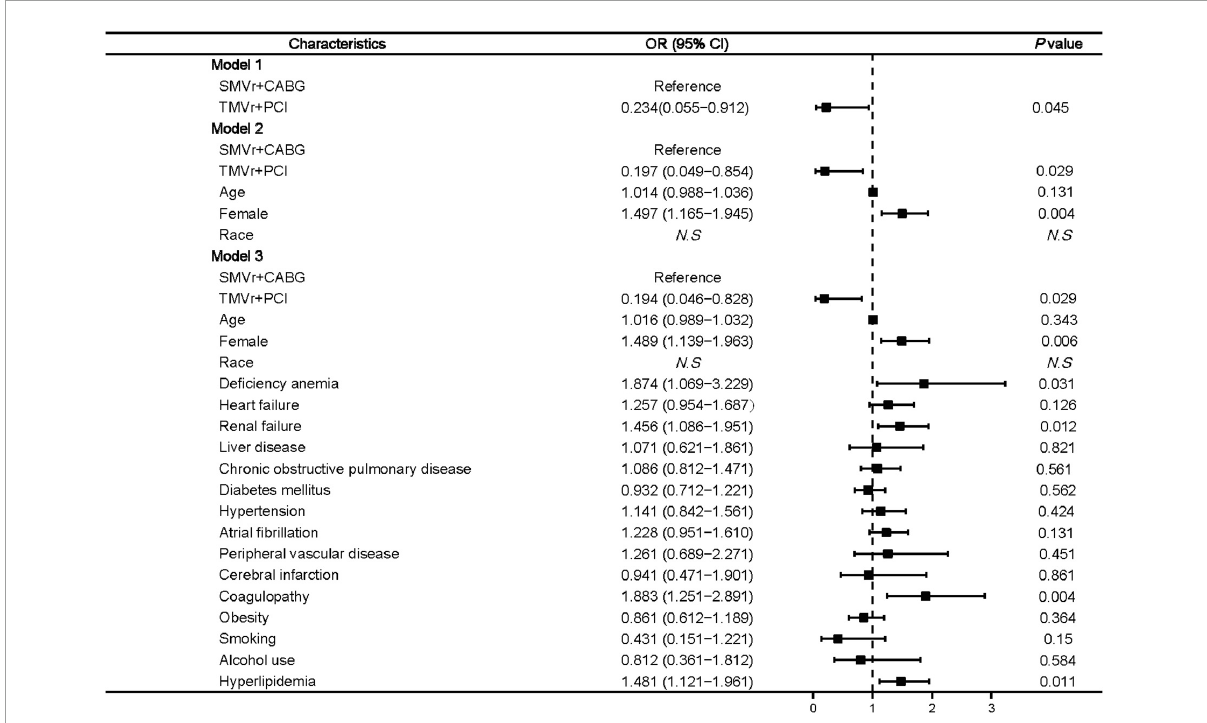
FIGURE4 Predictors of post-procedural blood transfusion in mitral valve insufficiency patients undergoing SMVr + CABG or TMVr + PCI. TMVr indicates transcatheter mitral valve repair; SMVR indicates surgical mitral valve repair; CABG indicates coronary artery bypass grafting; PCI indicates percutaneous coronary stent implantation; model 1 indicates the univariate regression analysis; model 2 adjusted for SMVr + CABG, TMVr + PCI, age, female, race; model 3 adjusted for SMVr + CABG, TMVr + PCI, age, female, race, deficiency anemia, heart failure, renal failure, liver disease, chronic obstructive pulmonary disease, diabetes mellitus, hypertension, atrial fibrillation, peripheral vascular disease, cerebral infarction, coagulopathy, obesity, smoking, alcohol use, and